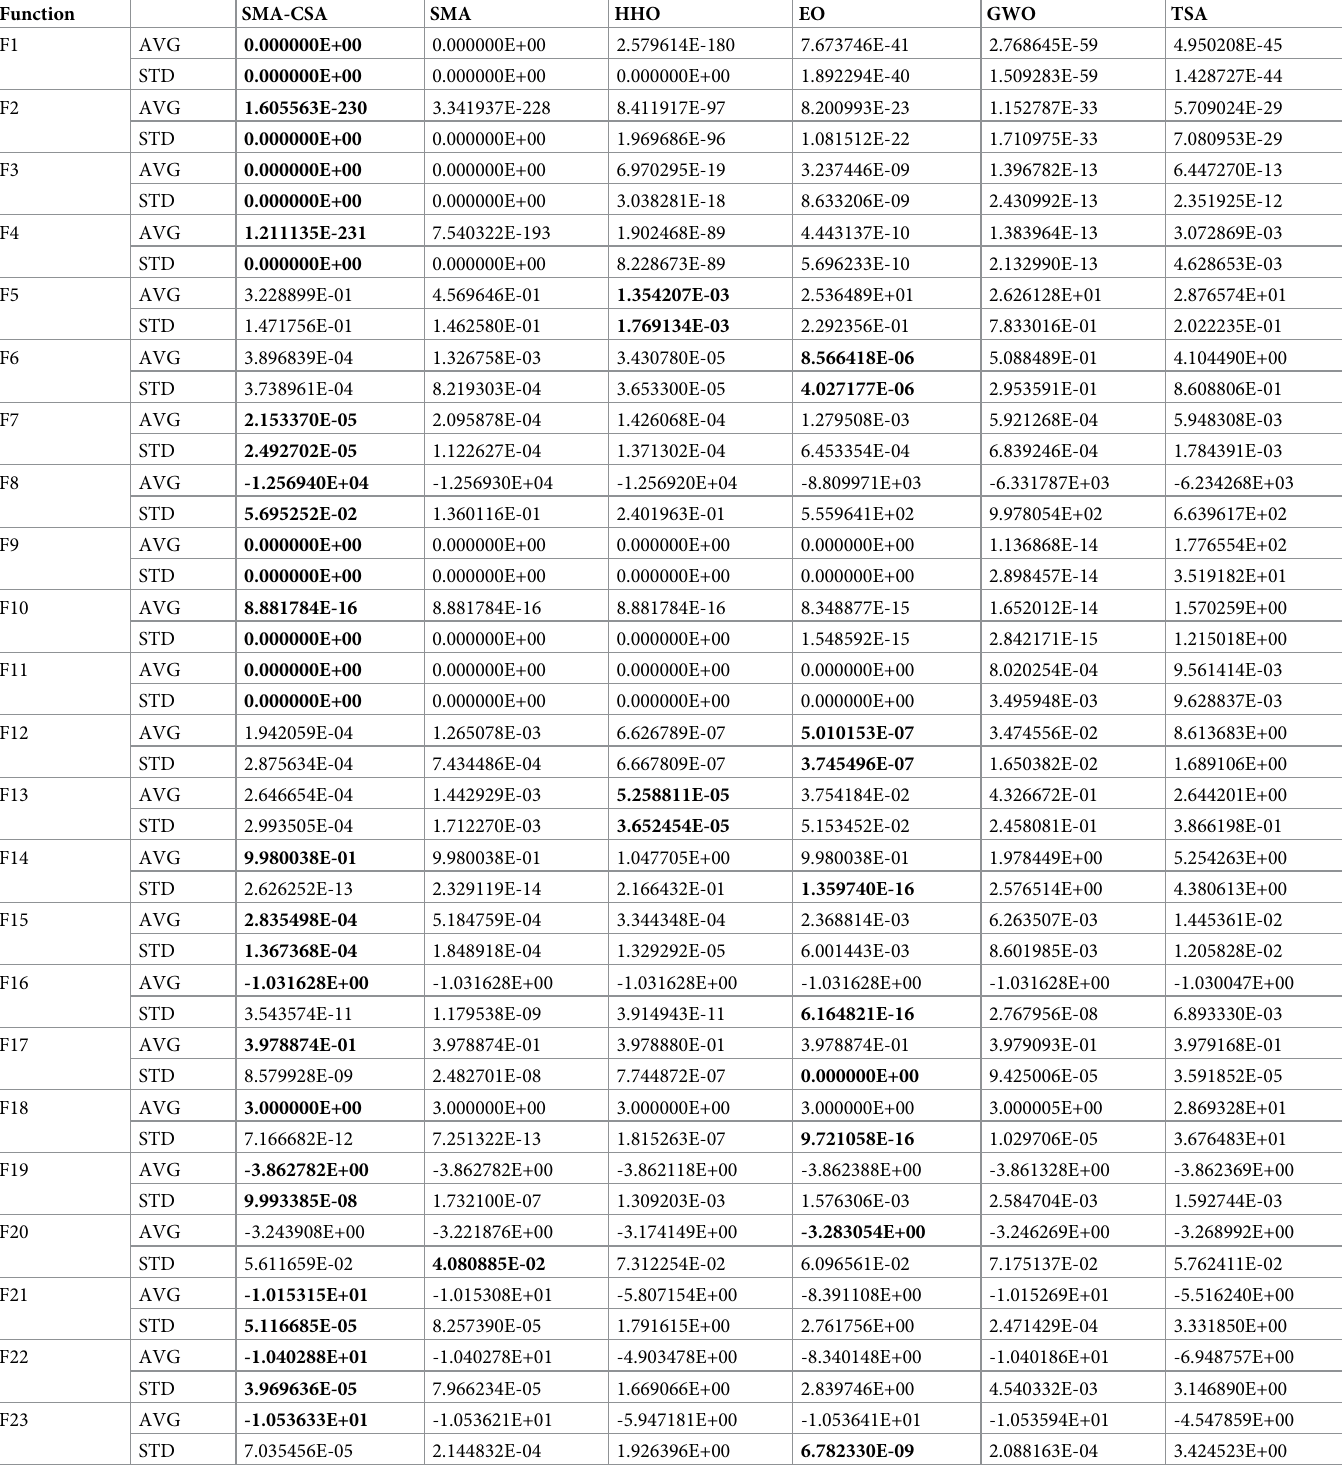
Table 5. Comparison results on benchmark functions with traditional